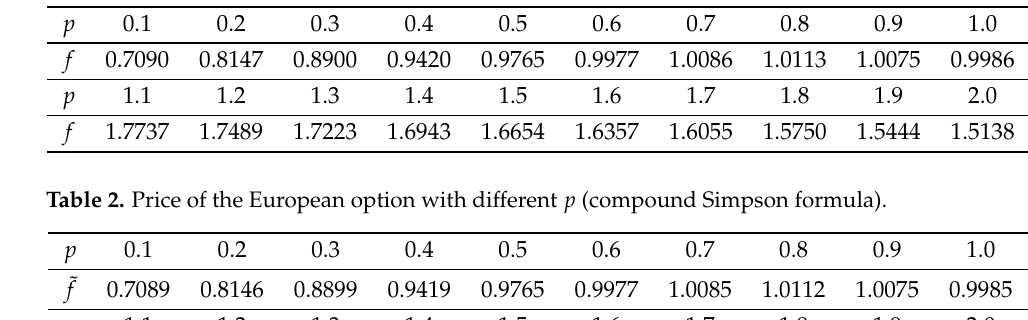
Table 1. Price of the European option with different p (compound Trapezoid formula).